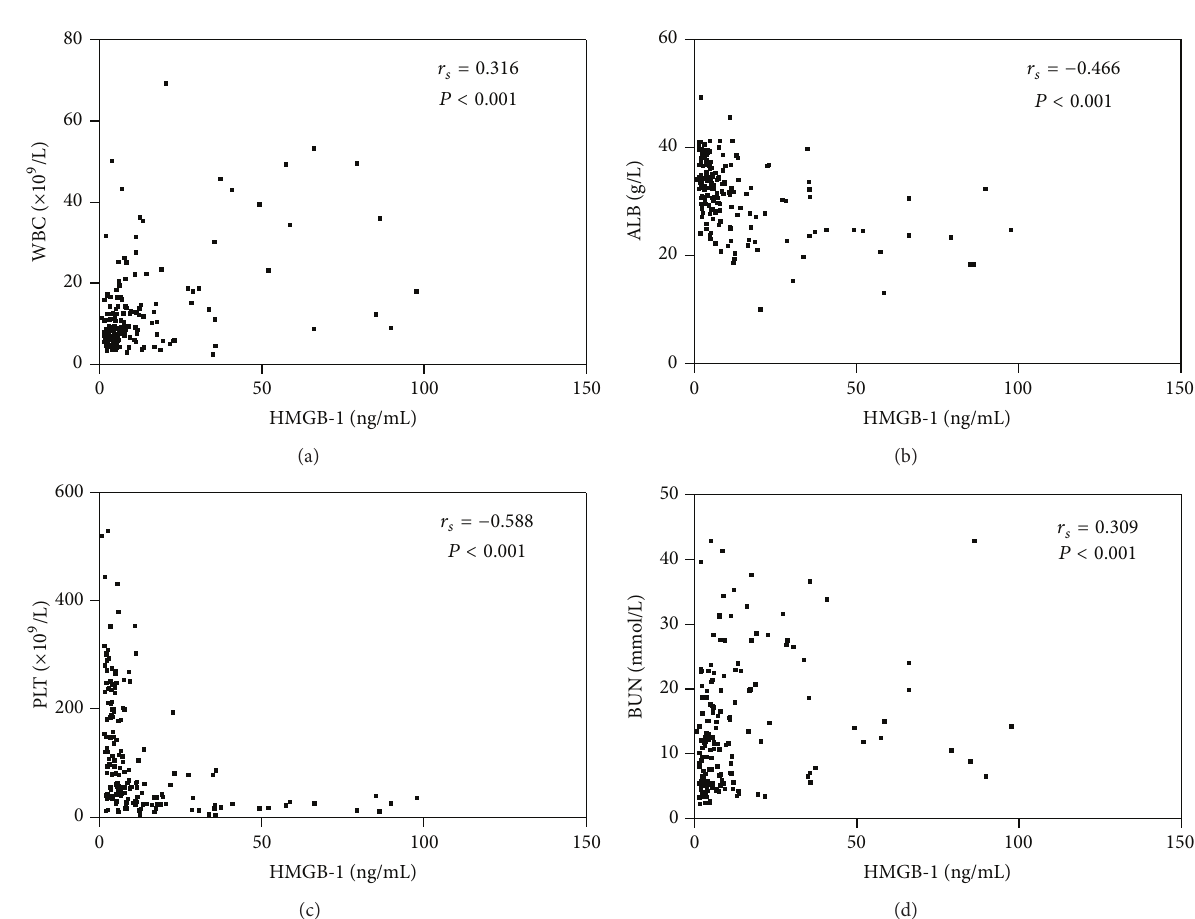
Figure 2: Correlation between HMGB-1 and WBC (a), ALB (b), PLT (c), and BUN (d) in patients with HFRS. HMGB-1, high mobility group box protein-1; WBC, white blood cells; PLT, platelets; ALB, albumin; BUN, blood urea